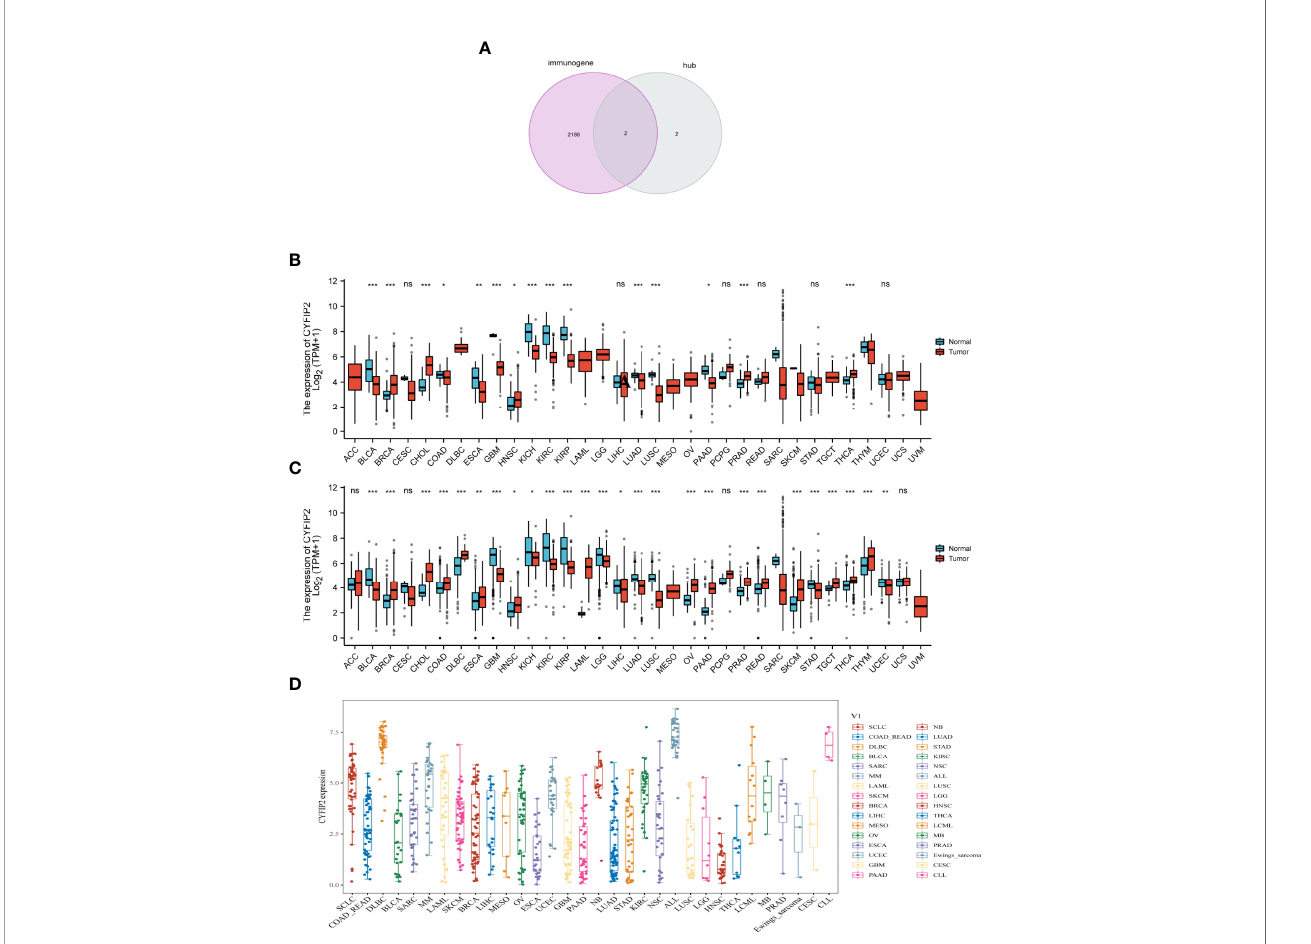
FIGURE 10 | CYFIP2 expression. (A) Venn diagram between immunogene and hub genes. (B) Pan – cancer expression levels of CYFIP2 in the TCGA dataset. (C) Pan – cancer expression levels of CYFIP2 in the TCGA and GTEx datasets. (D) Expression of CYFIP2 in various cell lines. *p <0.05, **p <0.01, ***p <0.001. NS, no signi fi